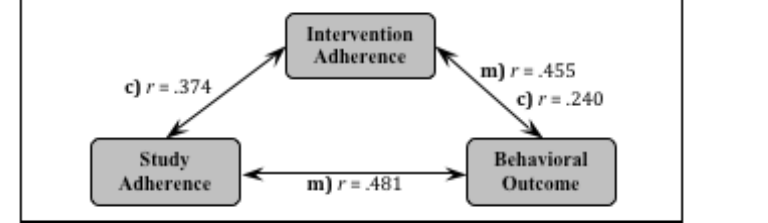
Behavioral OutcomesIntervention